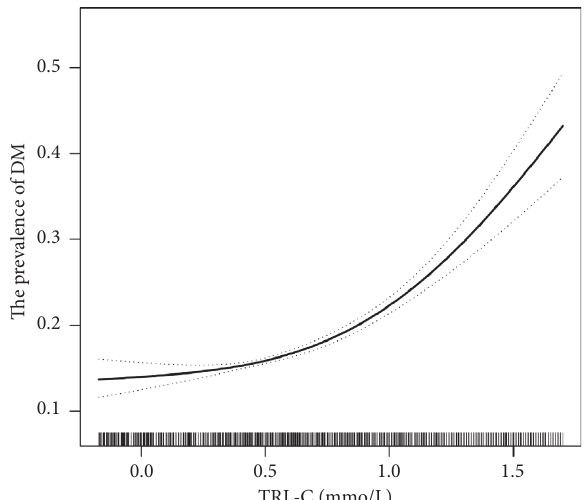
Figure 2: Dose-response relationship between the TRL-C and the prevalence of DM. Adjusted for age, sex, BMI, current smoking, current drinking, SBP, DBP, eGFR, history of stroke and CAD, and antihypertensive